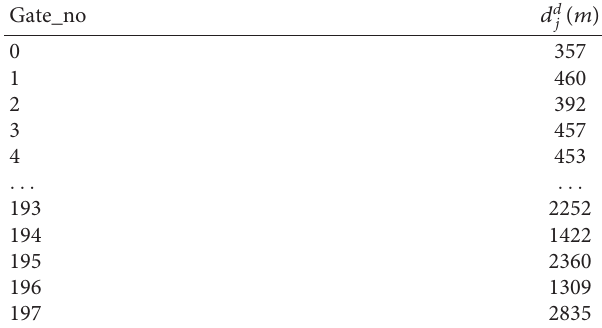
Table 9: Passenger travel distance from check-in counter to gate j .